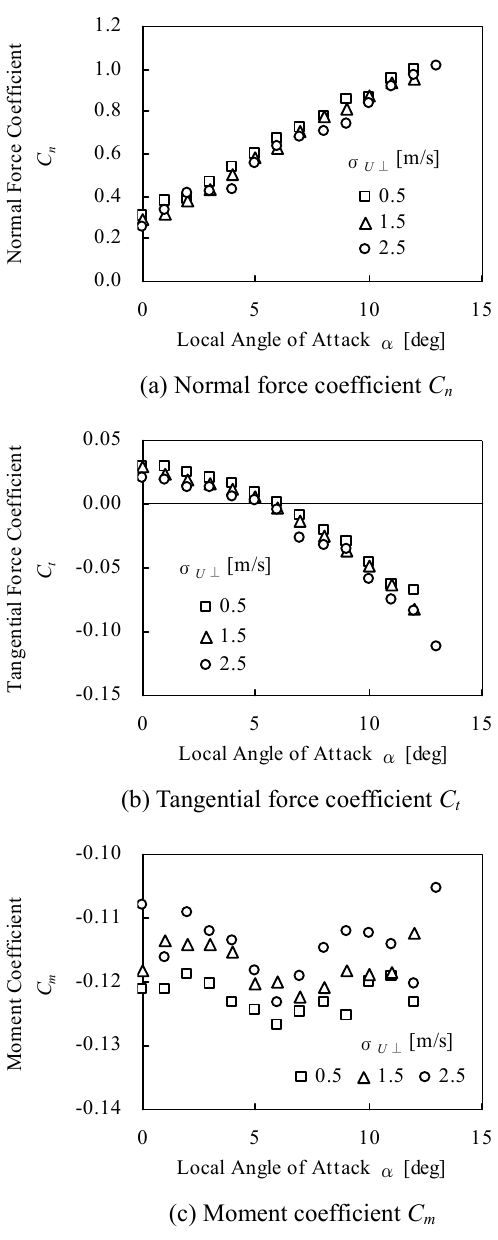
Fig.9 Section characteristics against local angle of attack α in several standard deviation of wind speed perpendicular to rotor plane σ